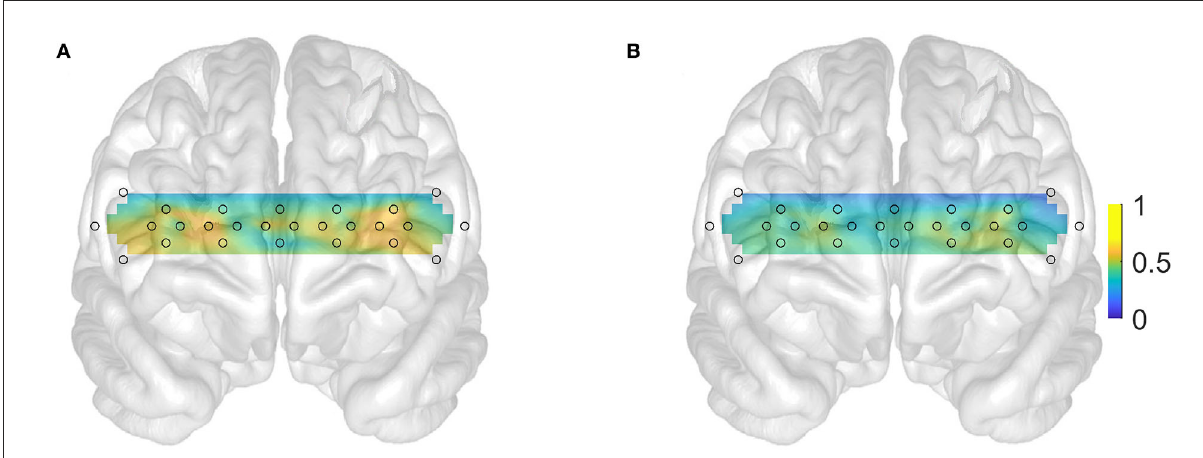
FIGURE1 Subject averaged prefrontal cortex activations (color bar units on the right in mM) interpolated from channels with 3.35cm separations. (A) Normal subjects (N = 18). (B) Patients (N = 21). Open gray circles indicate the location of the fNIRS